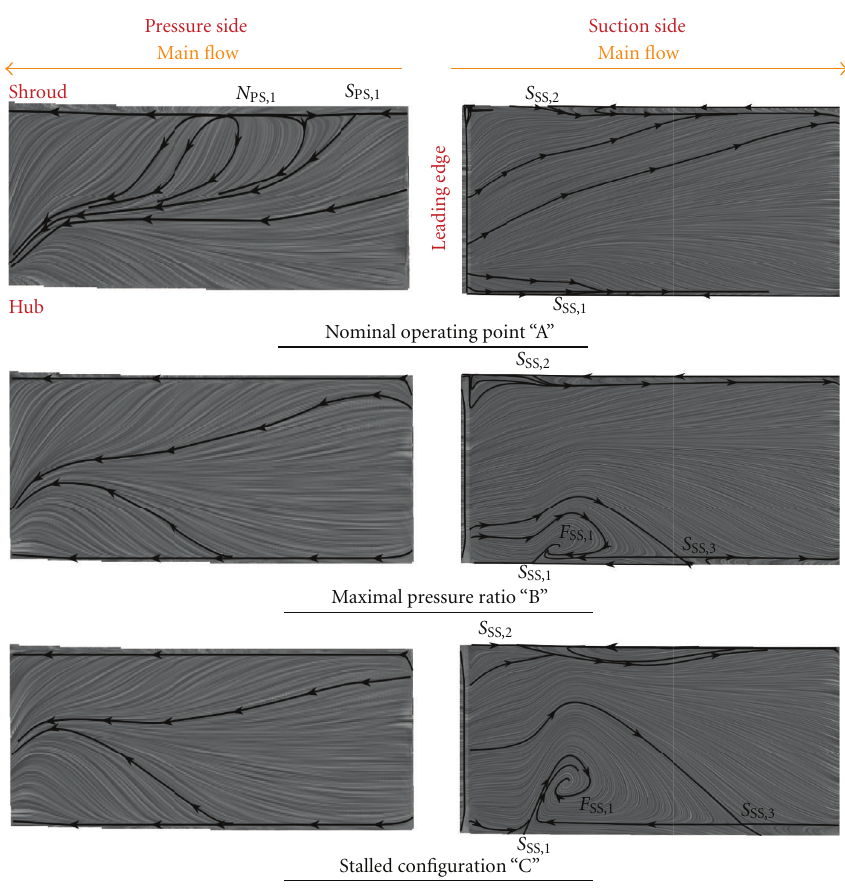
Figure 8: Skin-friction patterns on pressure and suction sides of di ff user vanes.